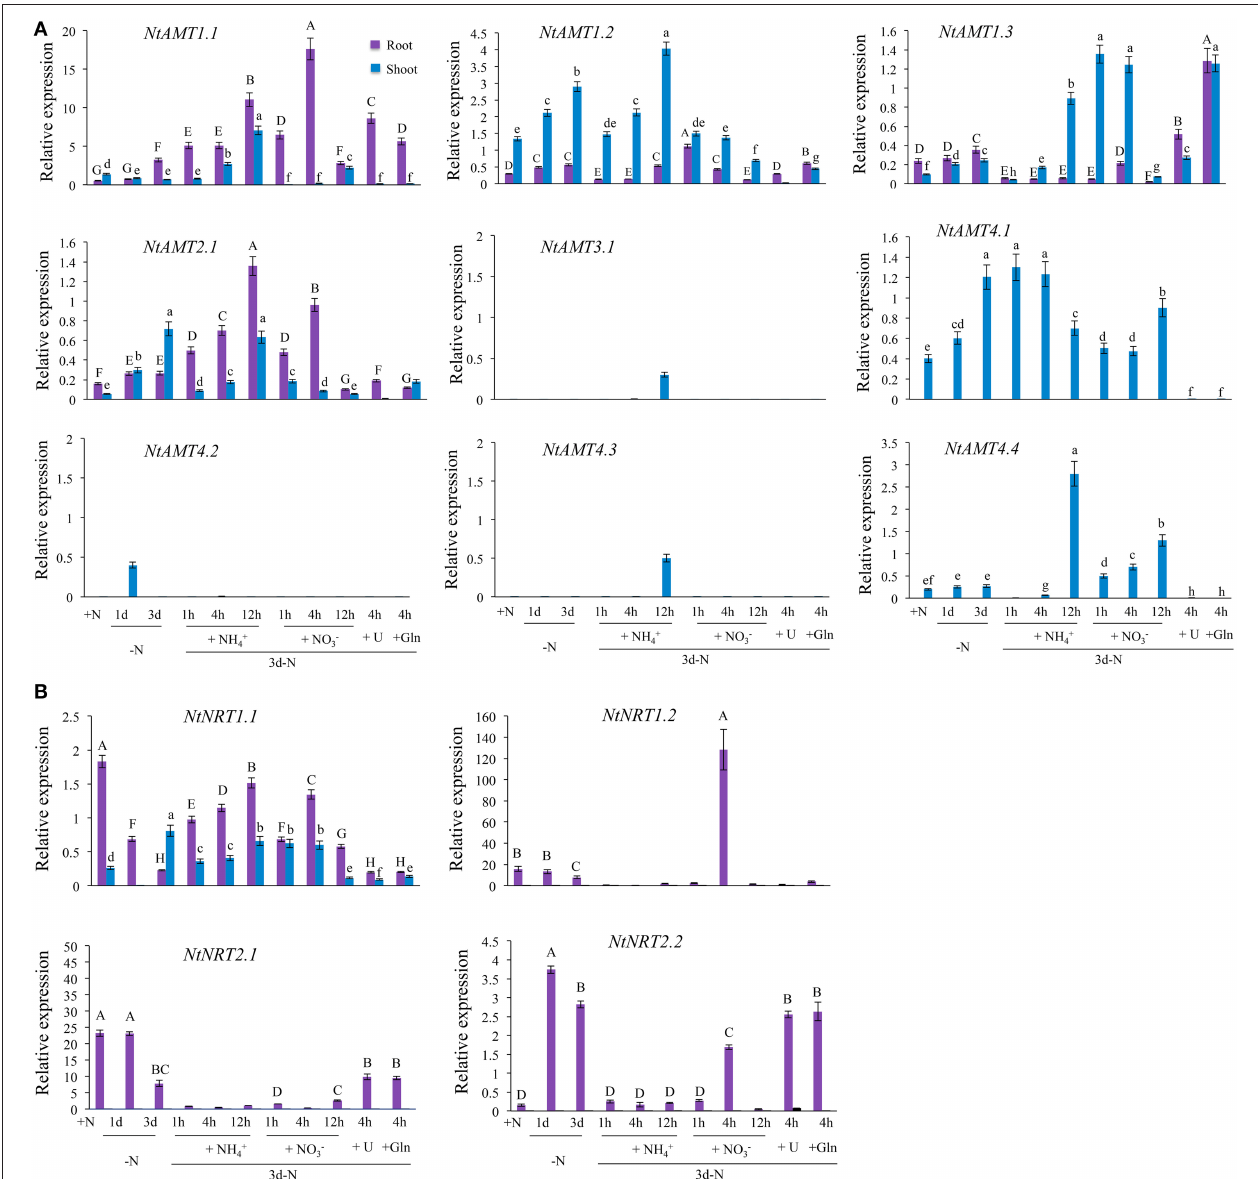
FIGURE 3 | N-dependent expression of AMTs (A) and NRTs (B) in roots and leaves of tobacco K326. Plant growth and N-treatment are described in section “Materials and Methods”. Total RNA was extracted from roots or leaves (1 d after fully-opened), and relative mRNA abundance of NtAMTs and NtNRTs was quantified by qPCR (see section Materials and Methods). Expression levels of AMTs and NRTs relative to that of α -tubulin (set to 1) were calculated. Data are means of 3–4 biological repeats ± SD ( n = 3–4); different letters above the bars indicate statistically significant differences ( P < 0.05 by one-way ANOVA and a multiple comparison test). + N, growth with normal N treatment; -N, N-starvation; 1d-N and 3d-N, N-starvation for 1 d or 3 d; N-resupply with NH + 4 (for 1, 4, 12h), NO − 3 (1, 4, 12h), urea (4h), and Gln (4h) after 3d-N. L25 was also applied as a reference to confirm the expression pattern (Figures S2C,D). Purple or blue bars indicate respectively root and leaf.